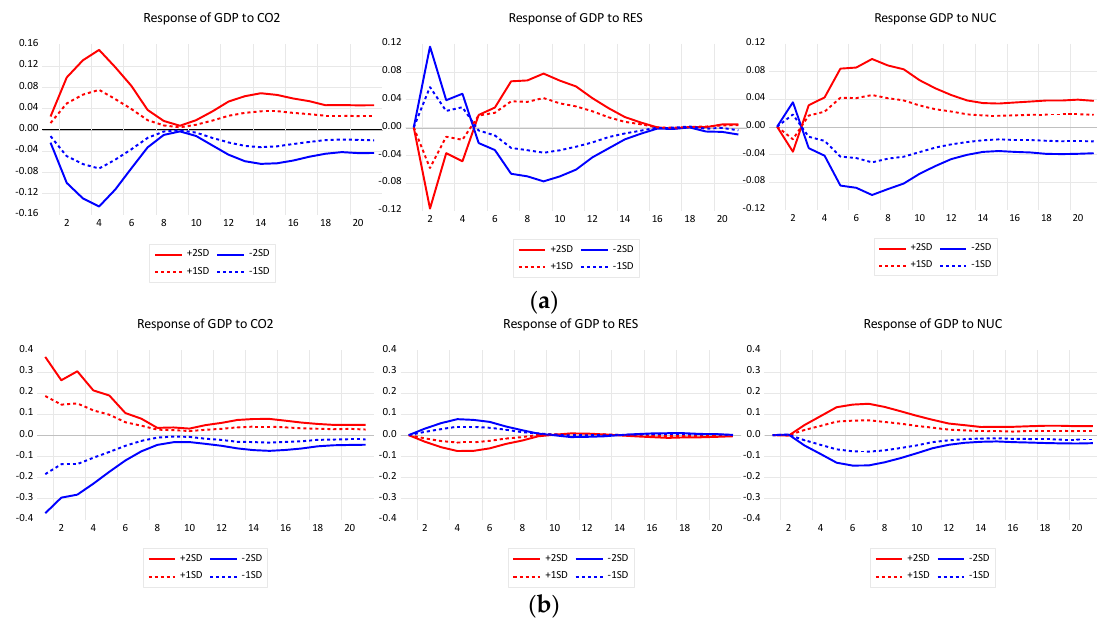
Figure 4. Responses of GDP to shocks in CO 2 emissions, nuclear and renewable energy consumption in ( a ) upper regime; ( b ) lower regime.